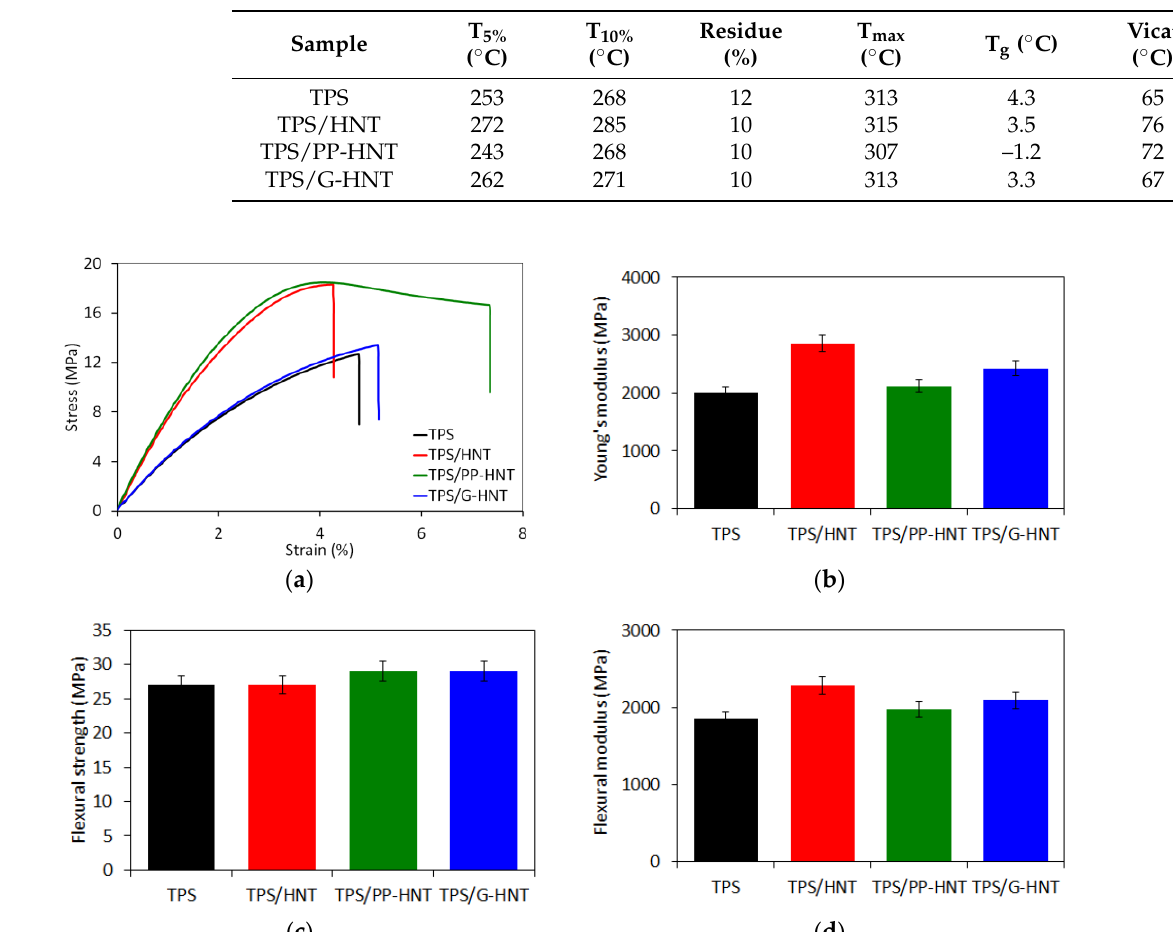
Figure 10. Stress–strain curves ( a ), Young’s modulus ( b ), flexural strength ( c ) and flexural modulus ( d ) of unmodified and halloysite-modified TPS.